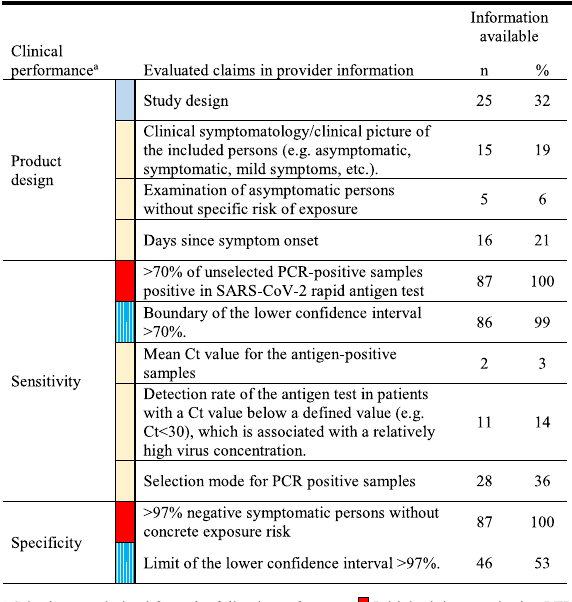
Table  : Availability of information on clinical performance char- acteristics in the test provider ’ s instructions for